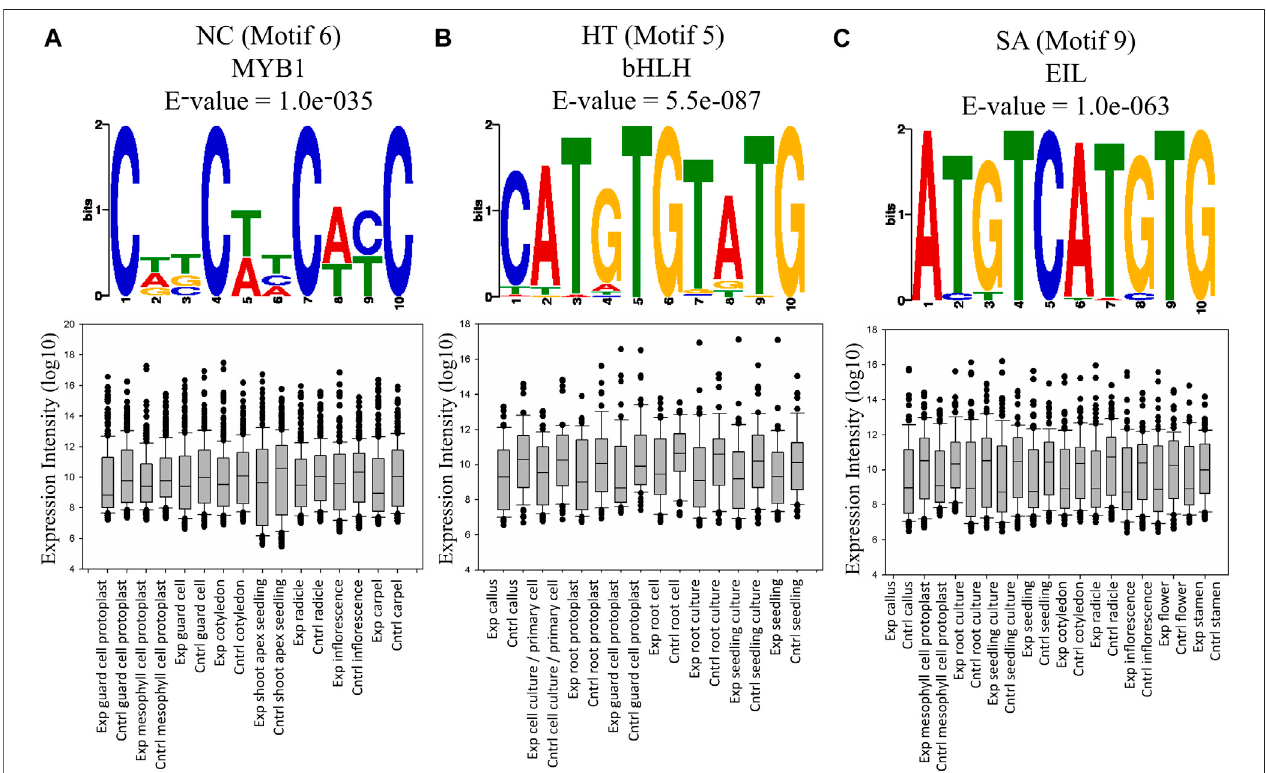
FIGURE 4 | The expression pro fi le of interacting protein-coding genes having the binding site for known TFs. In this fi gure, some of the conditions represented are showing a statistically signi fi cant difference over the control ( t -test p -value < 0.05). Interacting genes containing motifs for different TFs showed signi fi cantly lower expression in different tissues or plant parts. (A) Motif 6 of NC. (B) Motif 5 of HT. (C) Motif 9 of SA.